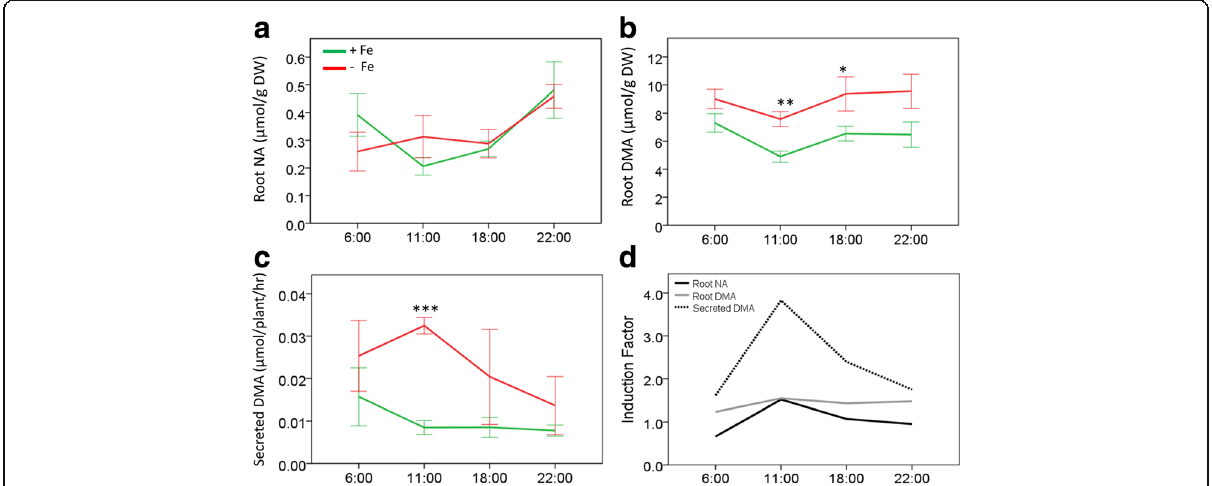
Fig. 3 Concentration of NA, DMA and secreted DMA of Fe-sufficient and Fe-deficient rice roots. Root concentrations of a NA ( n =5), b DMA ( n =5) and c DMA secretion ( n =3) from Fe-sufficient ( green ) and Fe-deficient ( red ) rice roots were quantified by LC-MS. d Induction factors of root NA, DMA and secreted DMA concentrations. Values are presented as means±SE of n biological replicates. Significant differences are indicated by * for p <0.05, ** for p <0.01, *** for p ≤ 0.001 as determined by Student ’ s t-tests performed between treatments within collection